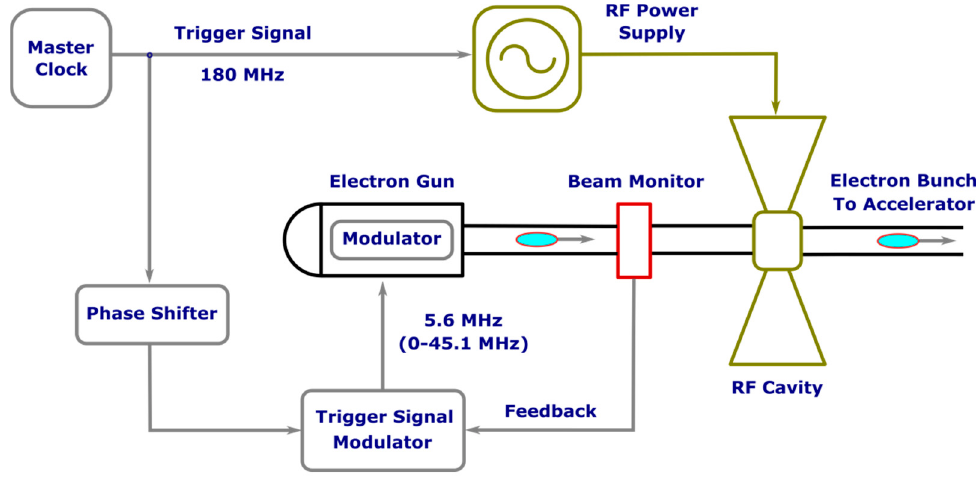
Figure 4. The injection phase shifting system.